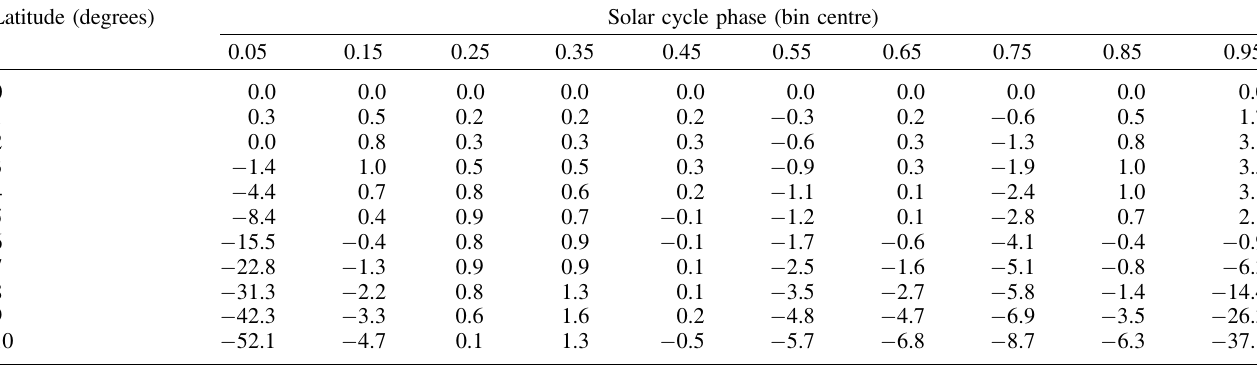
Table 1. The median values of the solar wind speed differences between the equator and other latitudes, i.e. V 0 (cid:3) V h , as a function of solar cycle phase and latitude. All values are given in km s (cid:3) 1 .